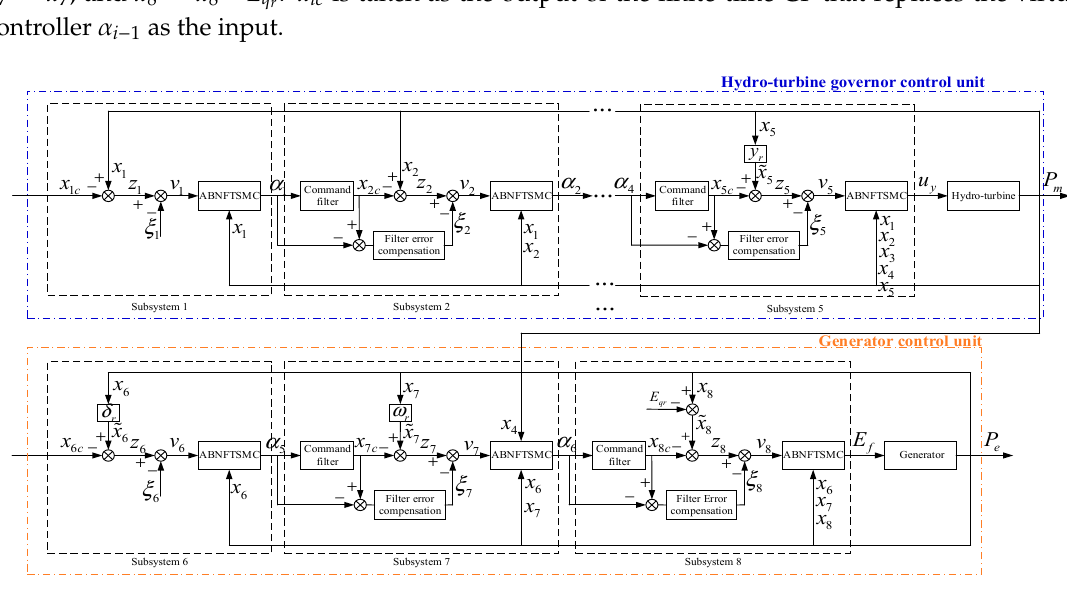
Figure 4. Block diagram for the proposed ABNFTSMC with CF in a HS.